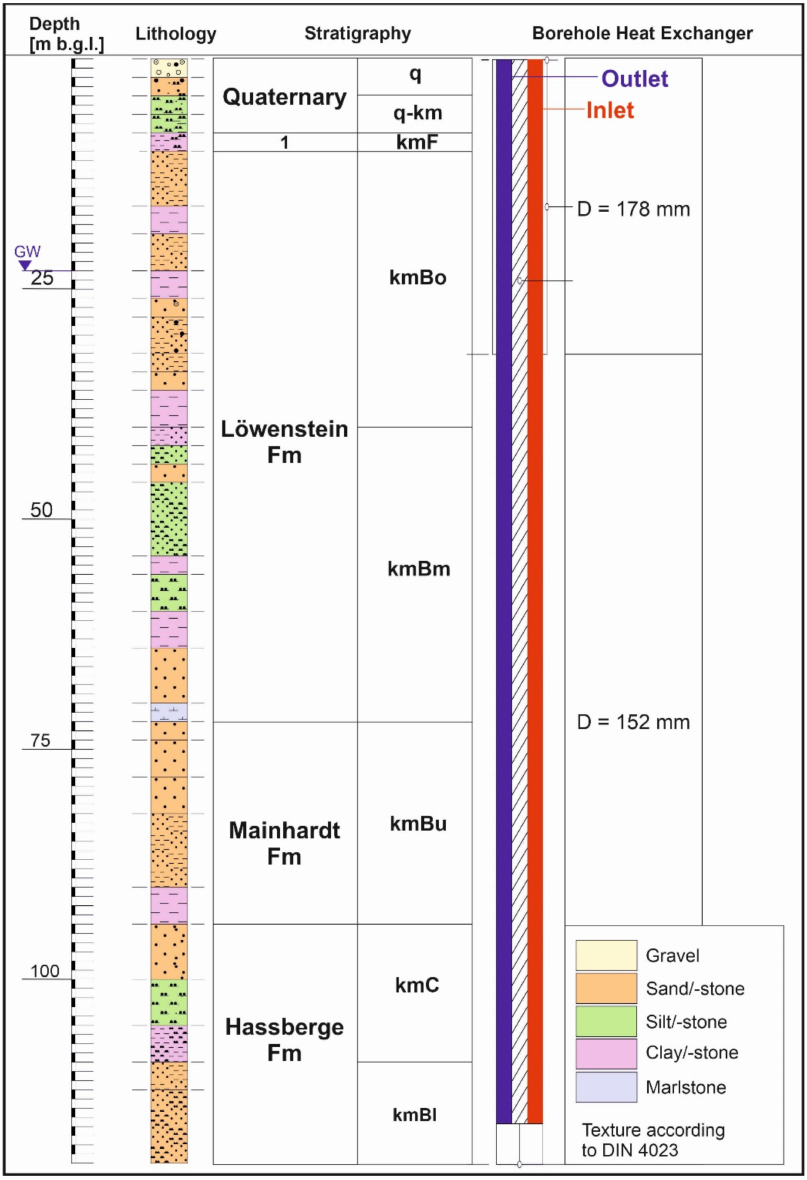
Figure 1. Overview of the drilled borehole and the borehole heat exchanger (BHE); lithological units with meters below ground level (b. g. l.) are displayed as defined by the German guideline DIN 4023 [23]; the abbreviations for stratigraphy are q: Quarternary, km: middle Keuper, kmF: Feuerletten, kmBo: upper Burgsandstein, kmBm: middle Burgsandstein, kmBu: lower Burgsandstein, kmC: Coburger Sandstein, kmBl: Blasensandstein; 1: Trossingen Fm. All units of middle Keuper belong stratigraphically to the Norian and Rhaetian